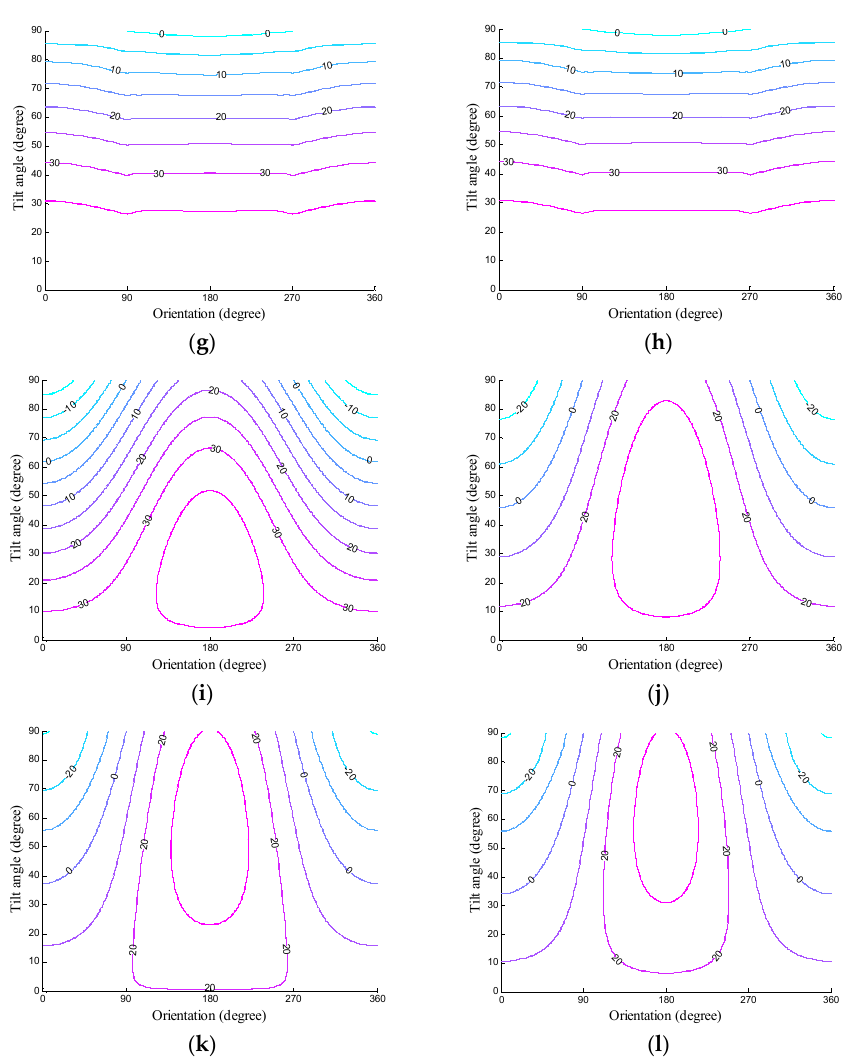
Figure 2. Monthly daily extraterrestrial solar radiation for various tilted angles and orientations in Shanghai: ( a ) Jan; ( b ) Feb; ( c ) Mar; ( d ) Apr; ( e ) May; ( f ) Jun; ( g ) Jul; ( h ) Aug; ( i ) Sep; ( j ) Oct; ( k ) Nov; and, ( l ) Dec.